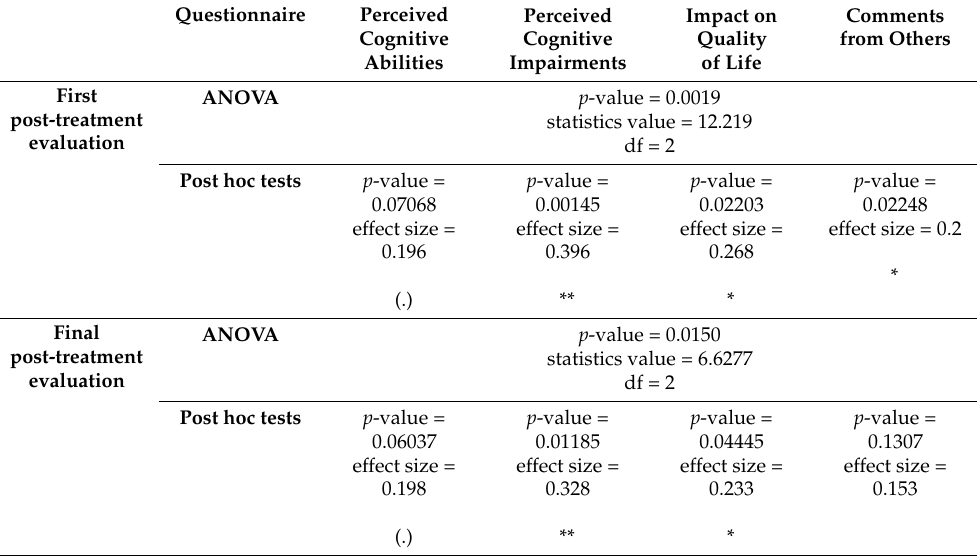
Table A5. Statistical tests performed after baseline correction to compare the hippotherapy and control groups, in order to assess the difference in score evolution for all the FACT-Cog items, at first post-treatment evaluation and final post-treatment evaluation. A robust between–within participants ANOVA was performed to evaluate as to whether the two therapies followed a different behavior with respect to the FACT-Cog items, for each questionnaire (Q2 and Q3). If significant, post hoc tests (two-sided Wilcoxon) were performed for each item to determine statistical differences between the two groups. (.) close to significance (between 0.08 and 0.05); (*) p < 0.05; (**) p < 0.01.